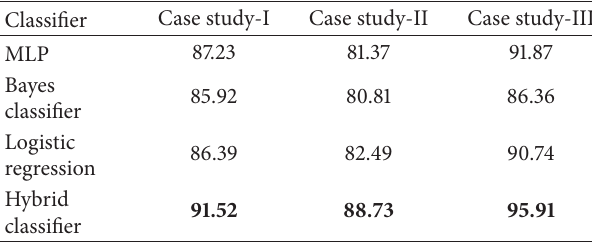
Table 9: Comparison of proposed hybrid classifier with other states of the art